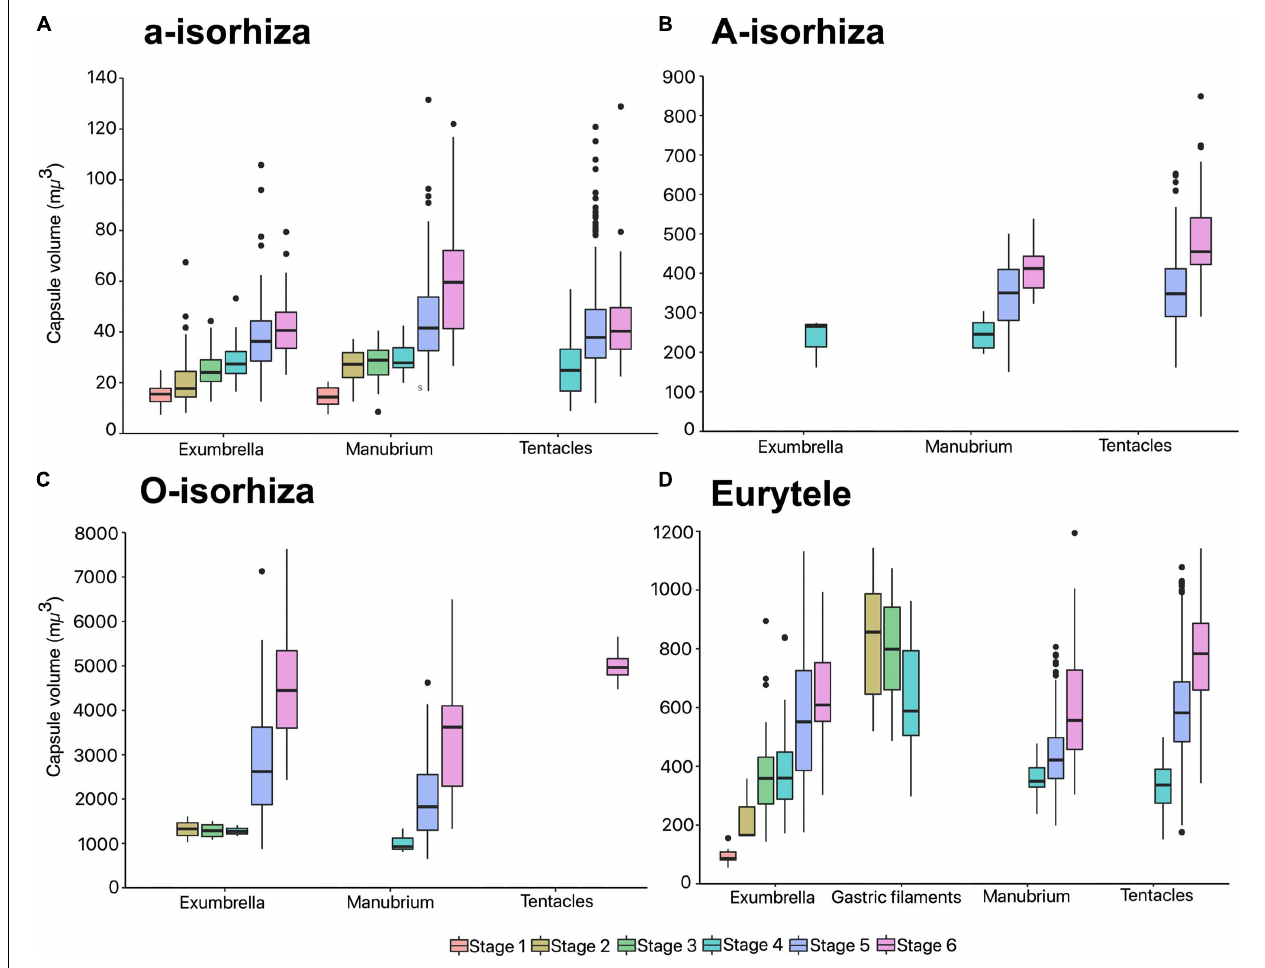
FIGURE 10 | Capsule volumes (CV) in different body parts during the life cycle of Pelagia noctiluca . (A) a-isorhizas (1389 nematocysts). (B) A-isorhizas (318 nematocysts). (C) O-isorhizas (246 nematocysts). (D) Euryteles (1487 nematocysts). Box plots with bottom and top of the box as first and third quartiles and horizontal line inside the box as second quartile (median). Outlying data are plotted as black dots. Stages: ephyra, stage 1; ephyra, stage 2; metaephyra, stage 3; metaephyra, stage 4; juvenile medusa, stage 5; adult medusa, stage